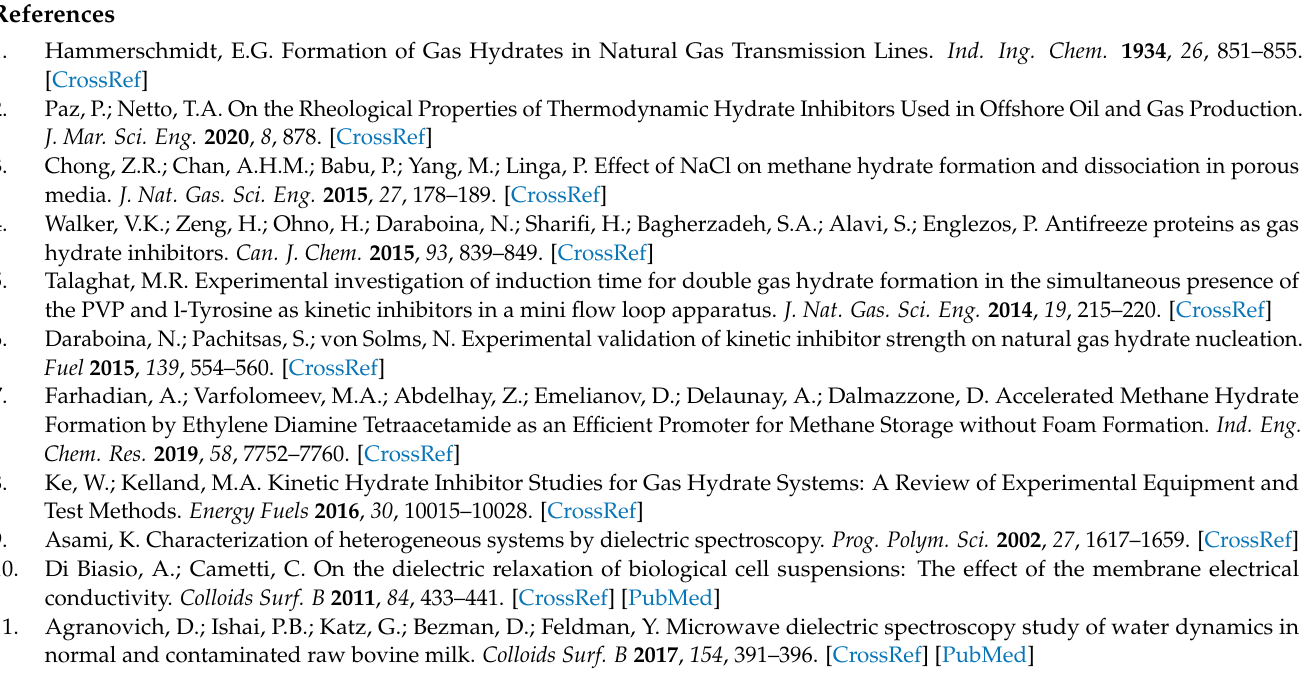
gas mixture; Figure S3: Comparison of time diagrams of hydrate formation at 9 MPa versus inhibitor concentration; Table S1: Fitting parameters for water; Table S2: Fitting parameters for PVCap sample 0.01 wt. %; Table S3: Fitting parameters for PVCap sample 0.05 wt.